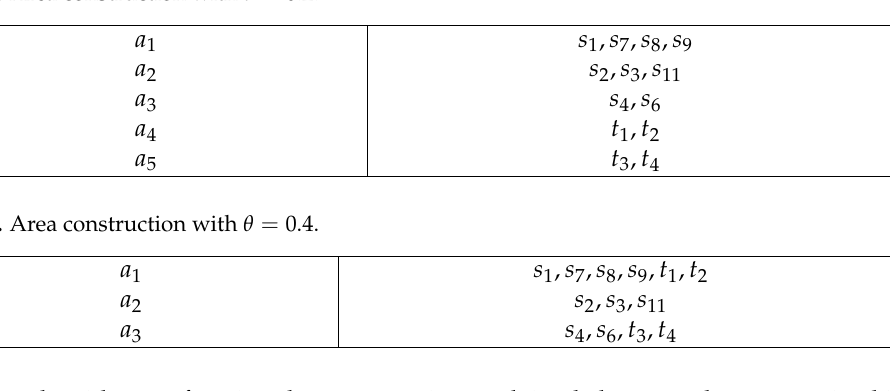
Table 3. Area construction with θ = 0.2.